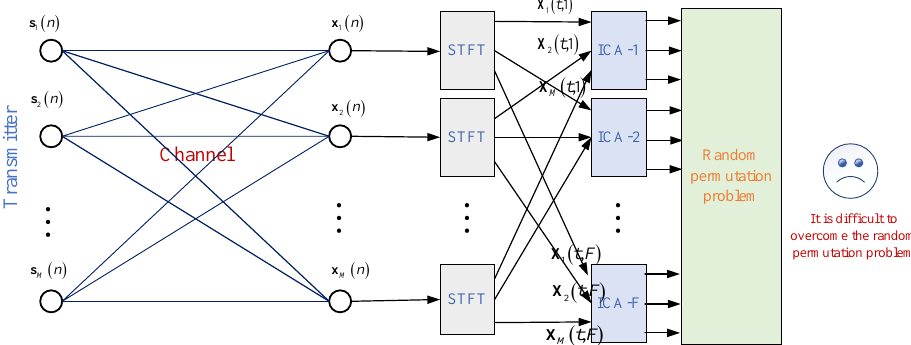
Figure 2. Convolutive mixture model with frequency-domain ICA detection receiver.